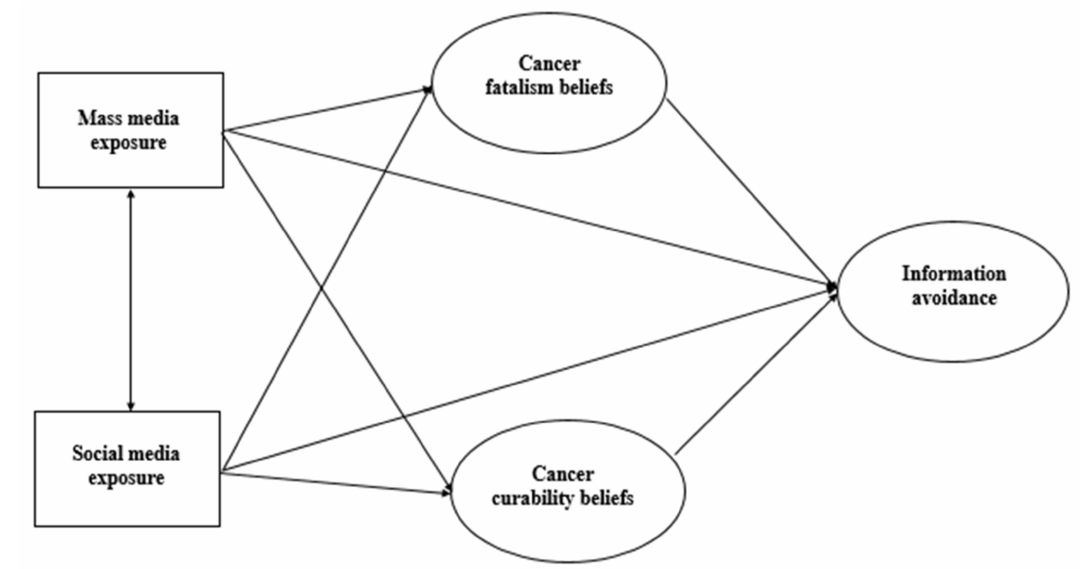
Figure 1. Structural model for cancer information avoidance (Model 1).